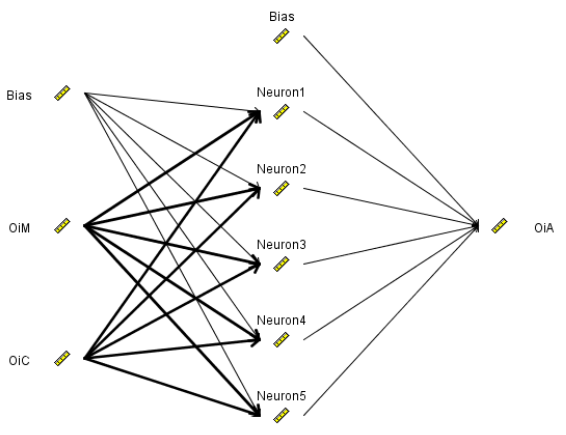
Figure 6. The ANN topology for the OiA outcome.